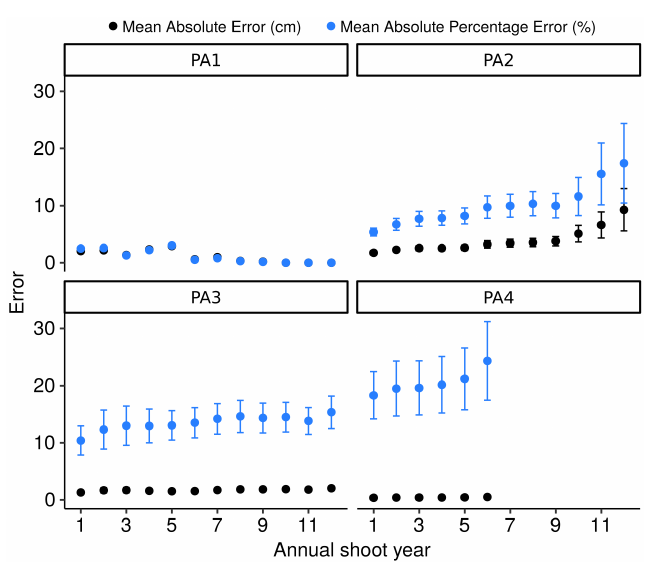
Figure 11. Mean absolute error and mean absolute percentage error ( ± standard deviation) of individual annual shoot length segmented by the annual shoot segmentation model as a function of production year for each physiological age (PA). Note that the y axis scale is the same for both indicators and that annual shoot year = 1 corresponds to the current year annual